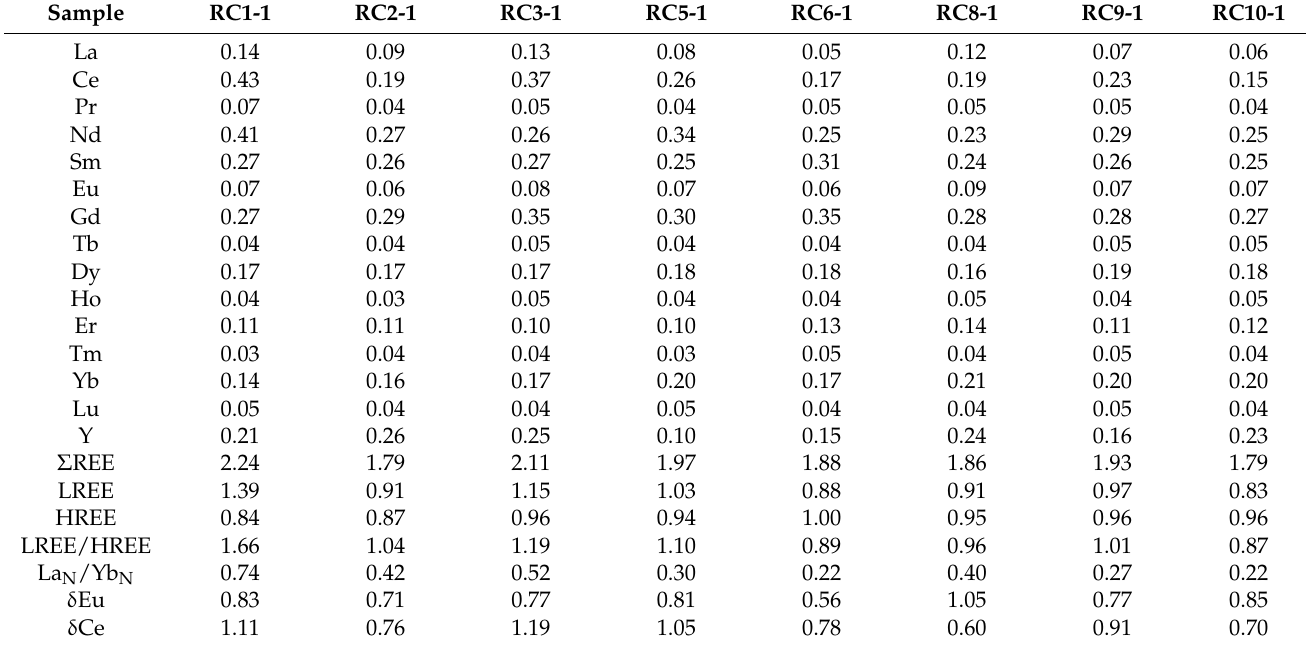
Table 3. Data on rare earth elements in the selected samples